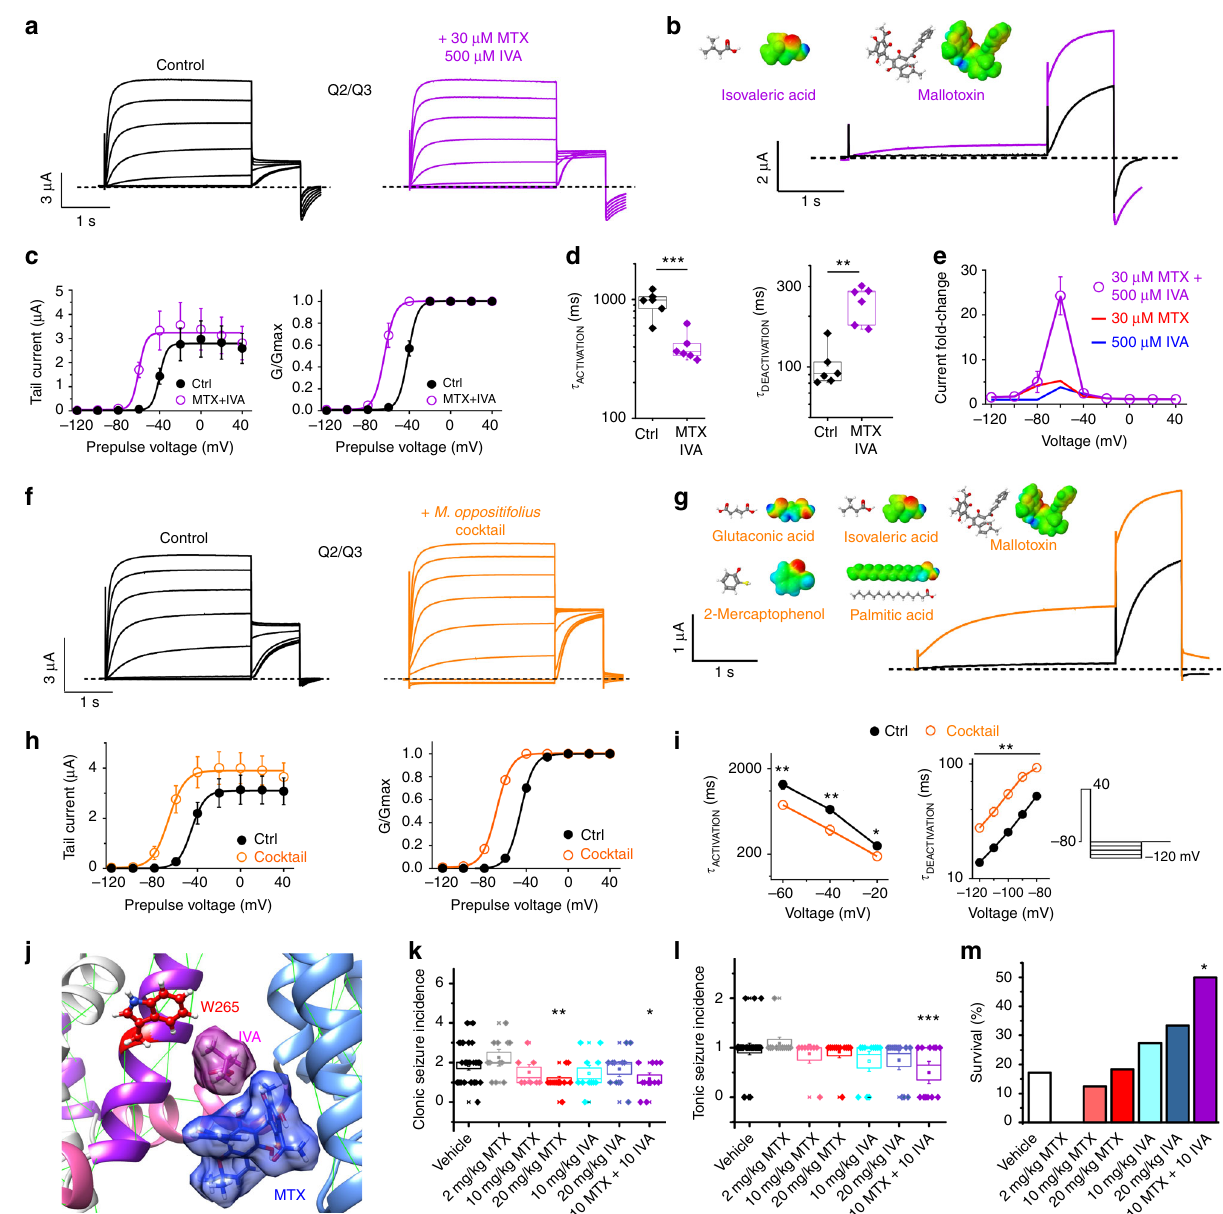
Fig. 6 MTX and IVA synergize to activate KCNQ2/3 and protect against seizures. a Averaged traces showing effects of IVA and MTX on KCNQ2/3 ( n = 5). Voltage protocol as in Fig. 1d. b Effects at − 60 mV highlighted, from traces as in a . c Mean tail current and G / G max from traces as in a ( n = 5). d Mean effect of IVA (500 µ M) + MTX (30 µ M) on KCNQ2/3 activation at + 40 mV and deactivation at − 80 mV ( n = 5). *** p = 0.0009; ** p = 0.001. e Mean KCNQ2/3 current fold-increase versus voltage induced by IVA and MTX alone (from Figs. 2 and 4) or in combination (from traces as in a ); n = 4 – 9. f Averaged traces showing effects of leaf extract cocktail (compounds shown in g ) on KCNQ2/3 ( n = 7). Voltage protocol as in Fig. 1d. g Effects at − 60 mV highlighted, from traces as in f . h Mean tail current and G / G = 7). i Mean effect of leaf extract cocktail on rates of max from traces as in f ( n KCNQ2/3 activation (left) and deactivation (center; voltage protocol on right) ( n = 7). * p < 0.05; ** p < 0.01. j Binding position of IVA and MTX in KCNQ3 predicted by SwissDock using a chimeric KCNQ1 – KCNQ3 structure model. k – m Effects of vehicle ( n = 35) compared to IVA and MTX alone or in combination ( n = 11 – 12) on k clonic seizure incidence, l tonic seizure incidence, and m seizure assay survival in a mouse PTZ chemoconvulsant assay. * p < 0.05; ** p < 0.01; *** p < 0.001. Survival statistical analysis by chi-squared, all others by one-way ANOVA. All error bars indicate SEM. All box and whisker plots: box range, 25 – 75%, coef fi cient 1; whisker range, 5 – 95%, coef fi cient